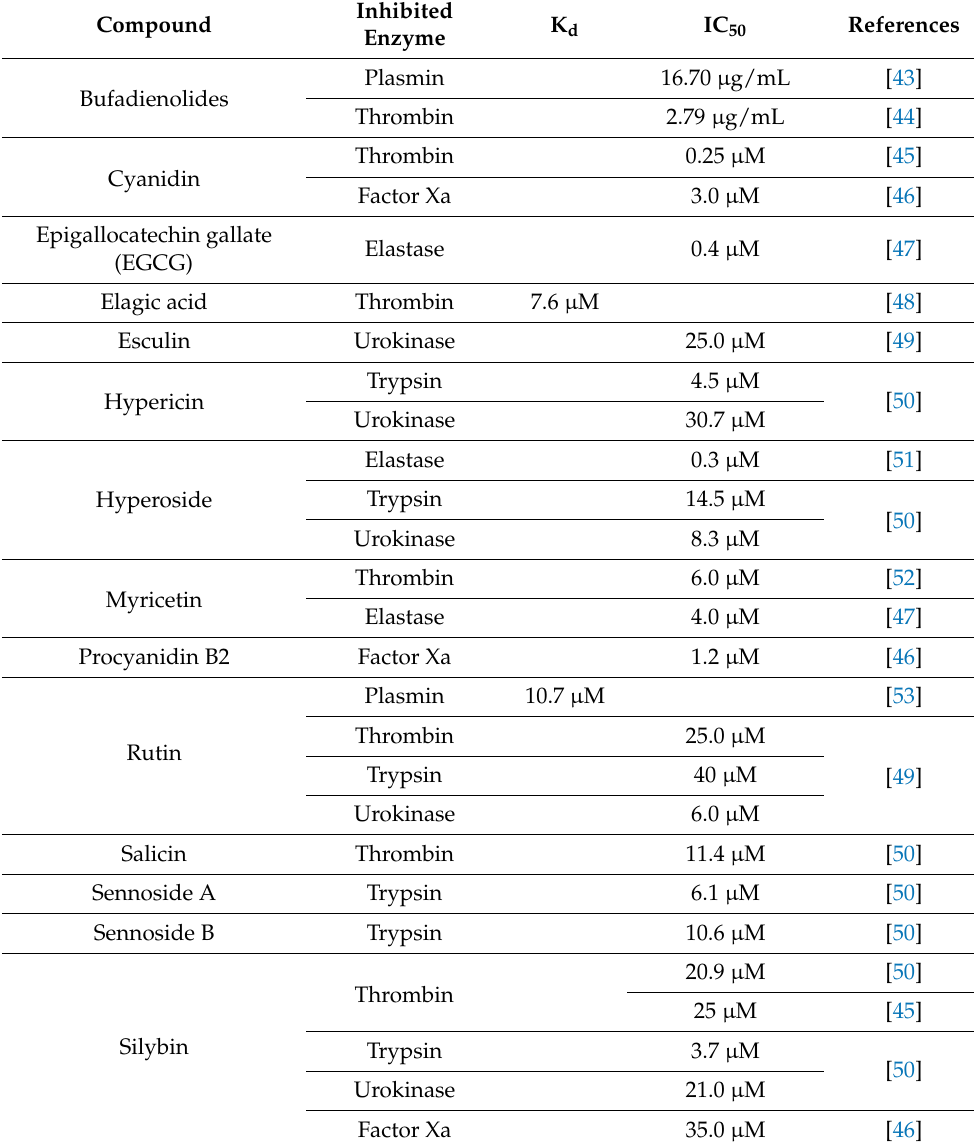
outcomes obtained from studies on native or modified peptides encourage further research on plant polypeptides as well. Studies on peptide-based plant inhibitors of serine proteases evidently indicate their higher efficiency when compared to (poly)phenolic compounds, for example, AVPI-12, a protease inhibitor from Aloe vera L. leaves with a unique RDWAEP- NDGY motif starting its N-terminal region inhibited the plasmin-mediated hydrolysis of human fibrin(ogen) in vitro with efficiency comparable to α 2-macroglobulin [56]. Both the Kunitz and other types of peptide inhibitors of different plant origin act mostly at nanomo- lar and even sub-nanomolar concentrations [57–68] (Table 4). In contrast, the most active plant polyphenolics are able to inhibit serine proteases or other enzymes at micromolar concentrations (Table 3). Table 3. The plant-derived substances with the highest potency in vitro to inhibit the serine proteases. Compounds with IC 50 ≥ 50 µ M have been considered weak inhibitors, and therefore they are not listed in this table. K d —dissociation constants of the serine protease-plant-derived compound complexes; IC 50 —half-maximal inhibitory